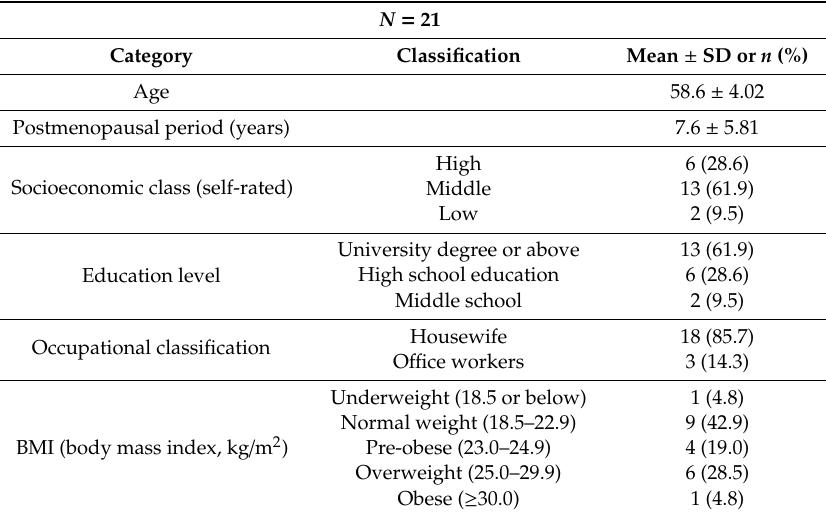
Table 1. General characteristics of